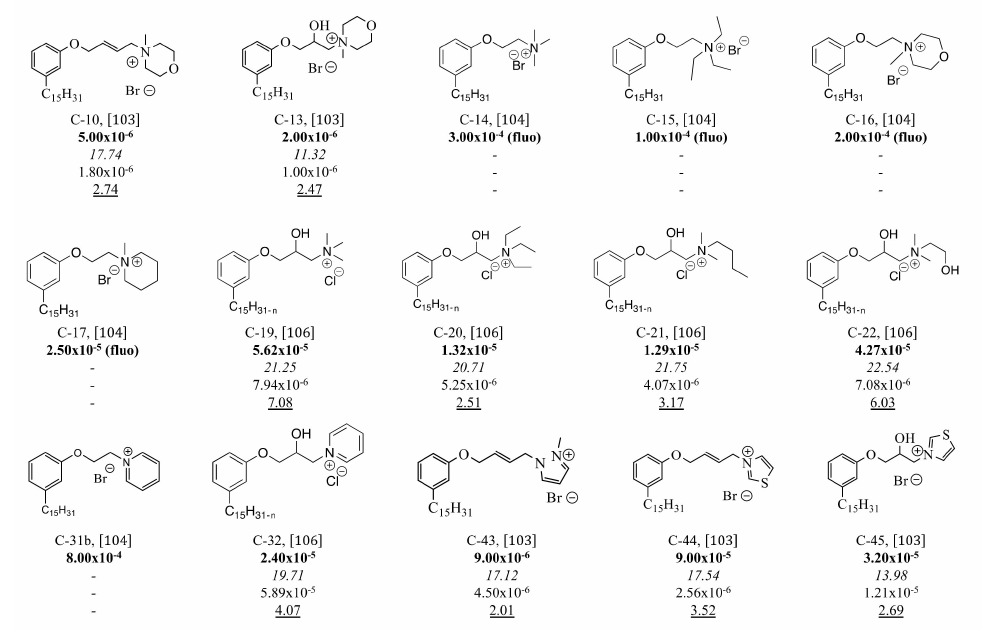
Figure 14. Effect of the polar head and/or the spacer on the CMC (mol/L, bold), γ CMC (mN/m, italics), C 20 (mol/L) and CMC/C 20 (underline) of cationic cardanol-based